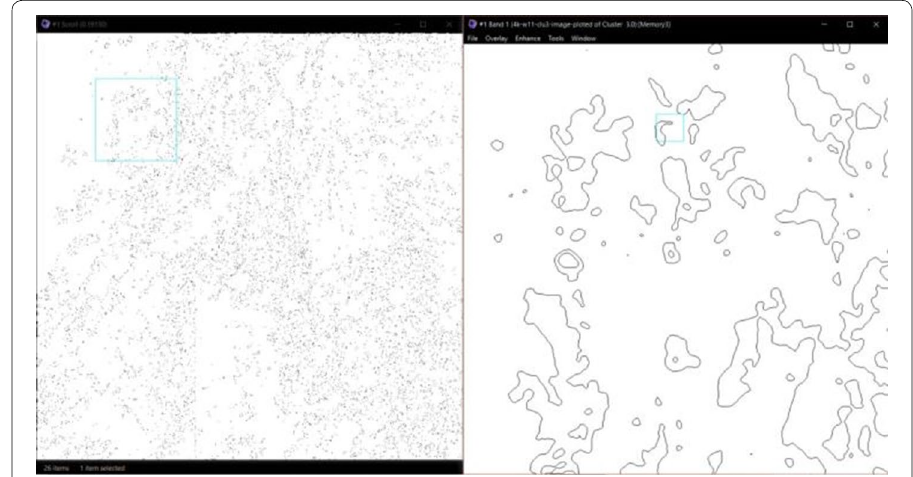
Fig. 11 Highlighting the boundaries of Cluster No. 3–4k image